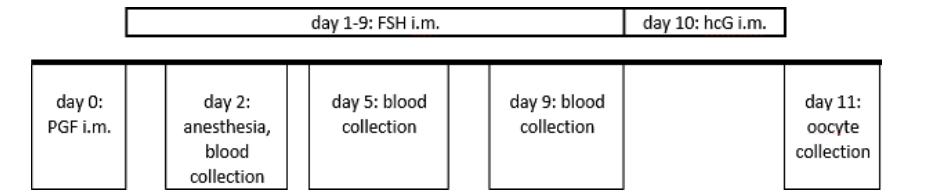
Figure 2. Ovarian stimulation and blood sampling protocol in the reported case. Routinely, blood collection is performed on day 2 on the non-anesthetized animal.